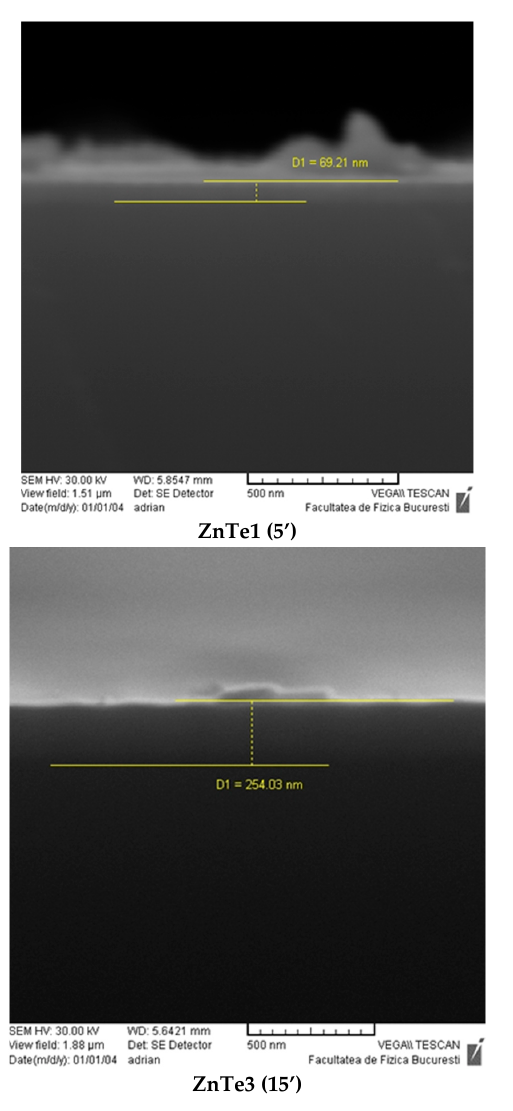
Figure 1. Examples of SEM images of cross sections of the fabricated ZnTe thin films (a local thickness estimation for each kind of film—the difference from the average values is due to local variations and it is in the errors limits).